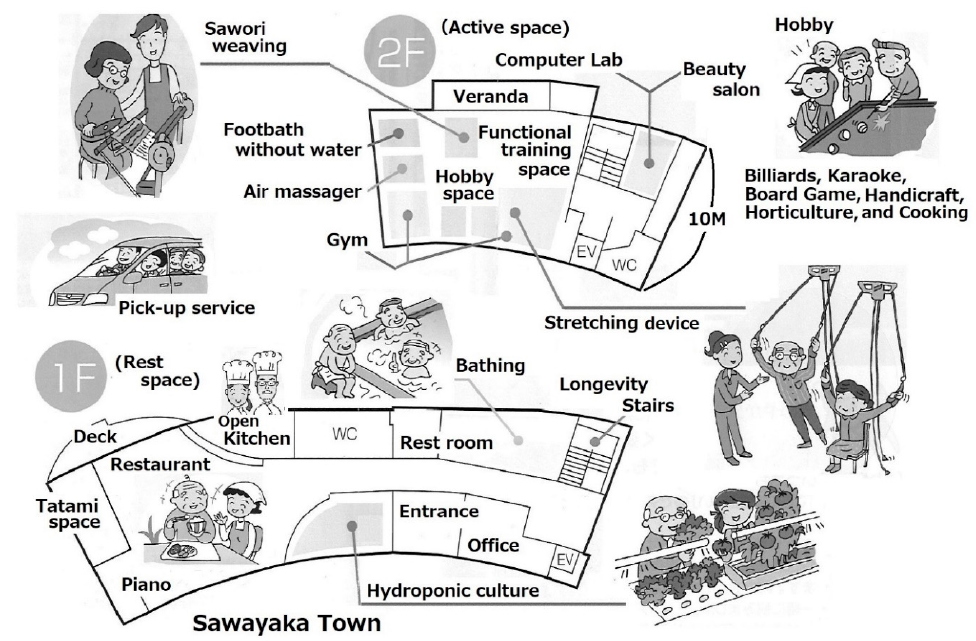
Figure 4. Functional areas of Sawayaka Town. Illustration: Sawayaka-Aichi brochure (used with permission and translated by the author).